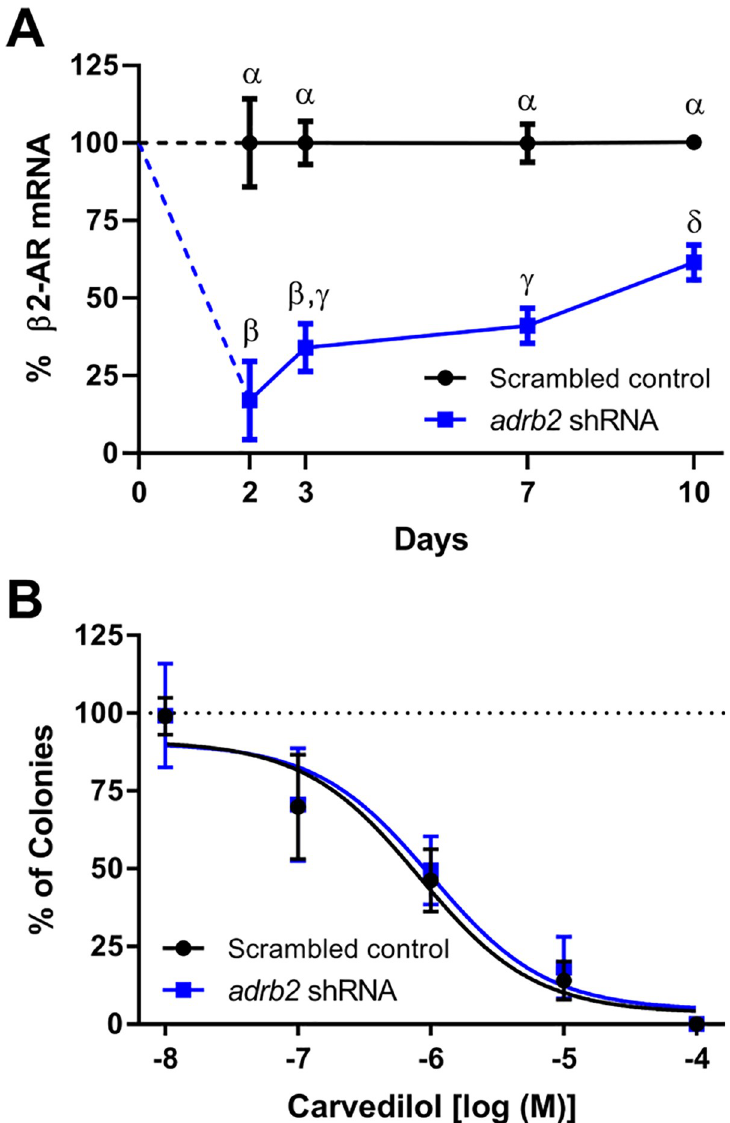
Fig 6. Knockdown of the β 2-AR fails to prevent carvedilol-mediated inhibition of EGF-induced neoplastic transformation of JB6 P+ cells. (A) qPCR indicates that transduction of JB6 P+ cells with lentiviruses carrying a short hairpin sequence for Adrb2 decreases β 2-AR expression, n = 3. Statistical analyses were determined using a 2-Factor ANOVA followed by Tukey Kramer post hoc test; different Greek letters signify statistical differences (P < 0.05). Data represented as mean ± SD. (B) After 3-days of infection, the JB6 P+ cells were exposed to 10 ng/ml EGF for seven days and increasing concentrations of carvedilol; n = 3 independent experiments with eight internal replicates detailed in Table 2. Data represented as mean ± SD after normalization to control (EGF alone minus DMSO